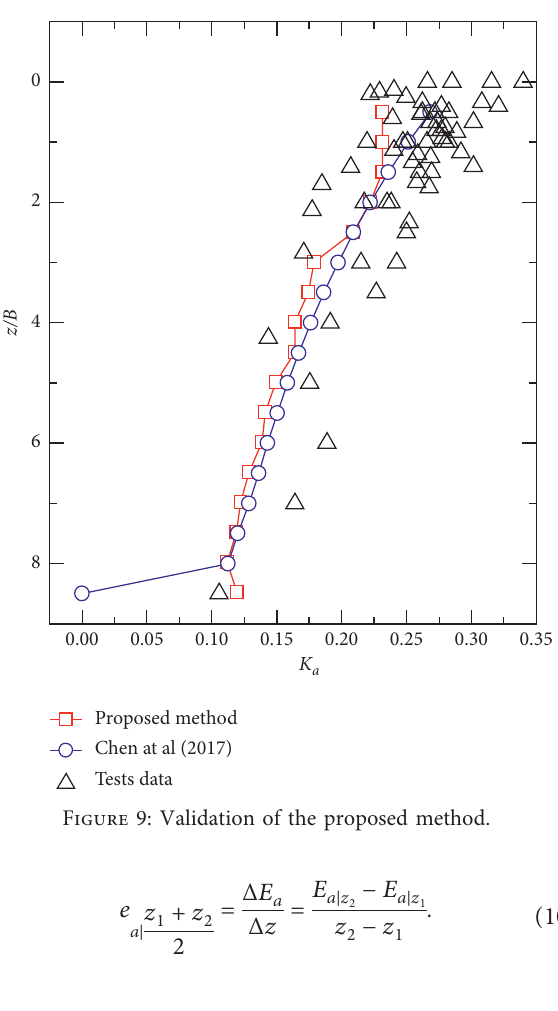
Figure 9: Validation of the proposed